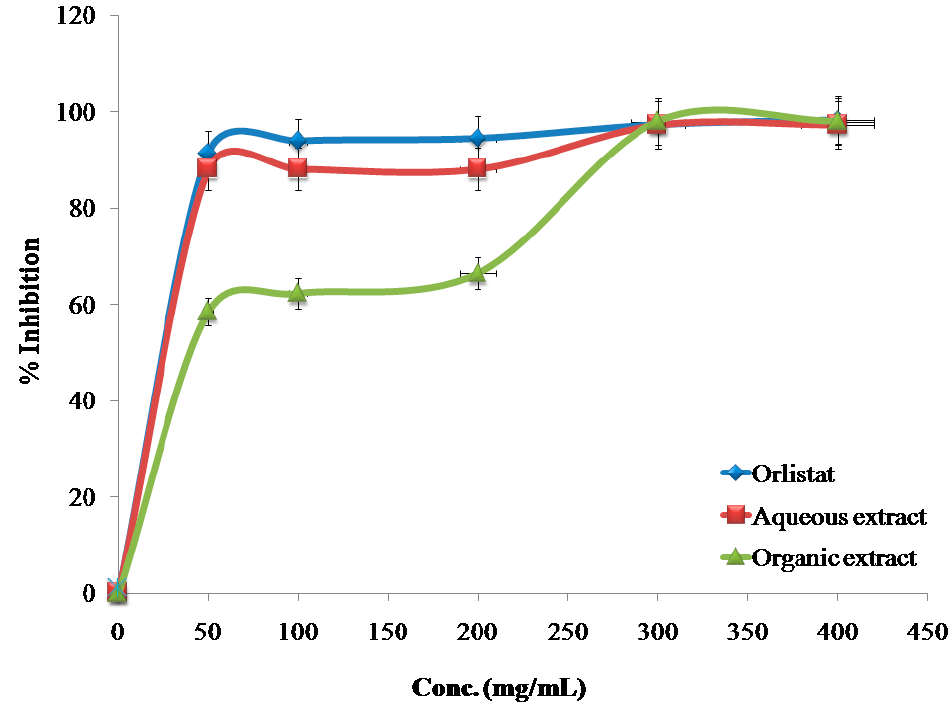
Figure 10. The inhibitory effects of the aqueous and organic extracts of V. vinifera and Orlistat on the activity of porcine pancreatic lipase.